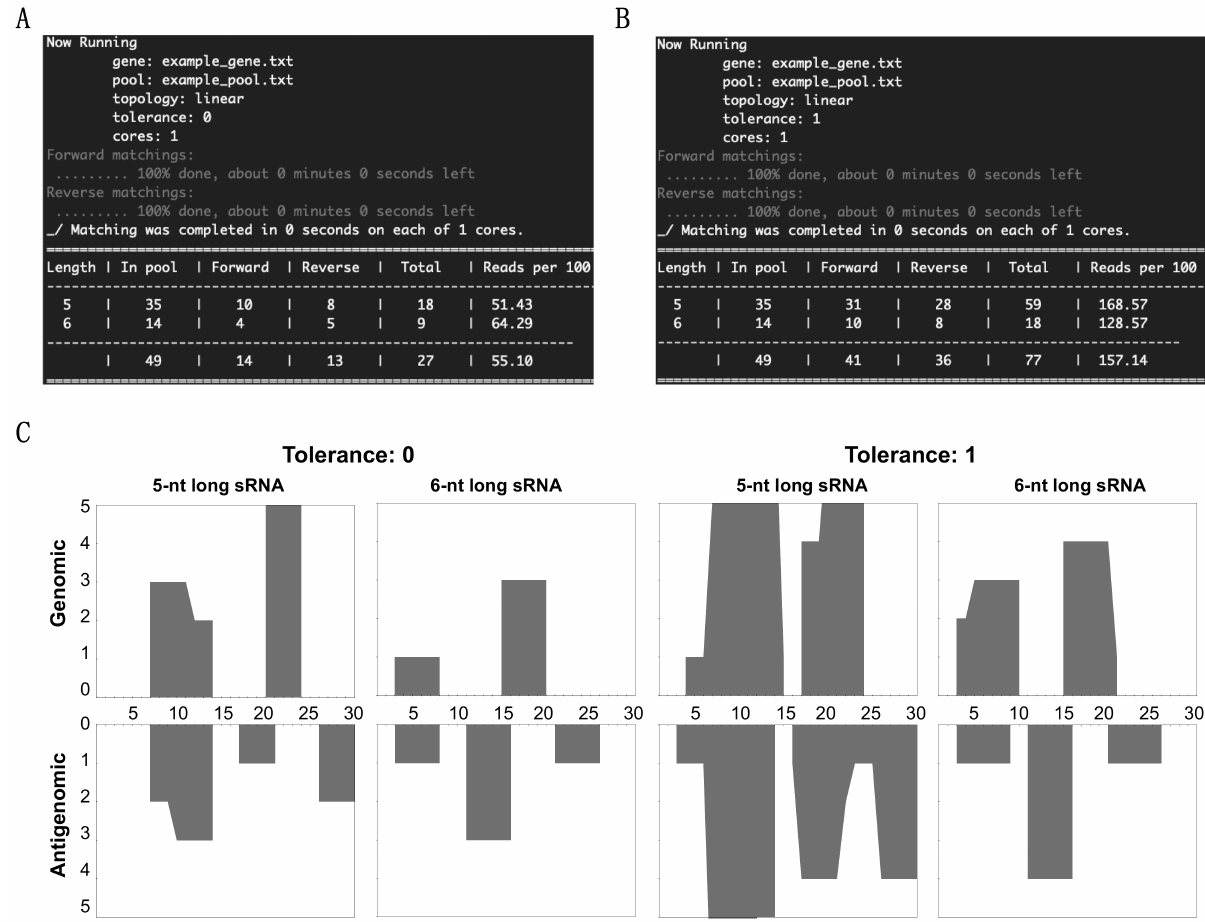
Figure 5. sRNA profiler data output for the linear RNA test sample. ( A ) Summary of the mapping data obtained from “0” tolerance and ( B ) “1” tolerance levels. ( C ) Profiling of the mapped sRNAs on the 30-nt long linear test genome at both the “0” and the “1” tolerance levels for 5- and 6-nts long